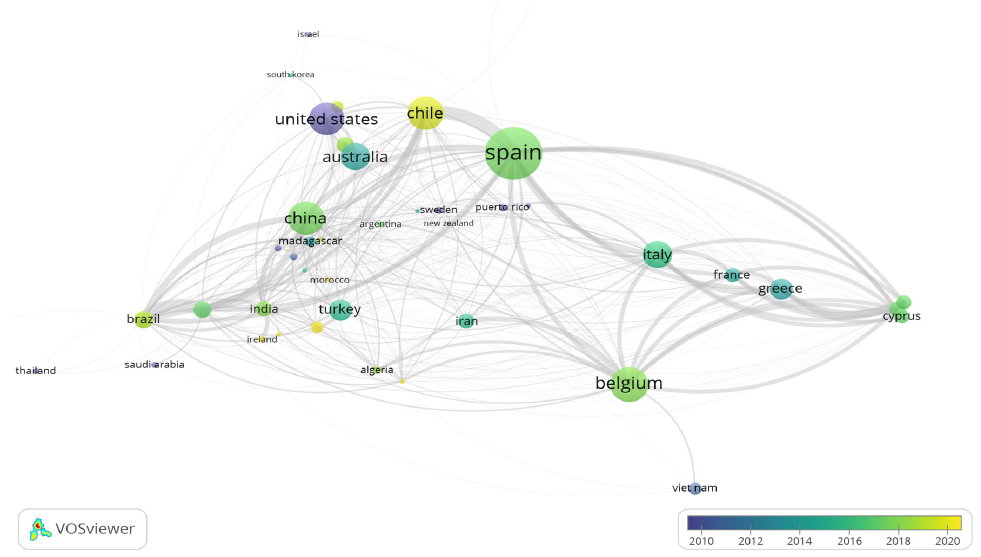
Figure 22. Bibliographic coupling of countries.